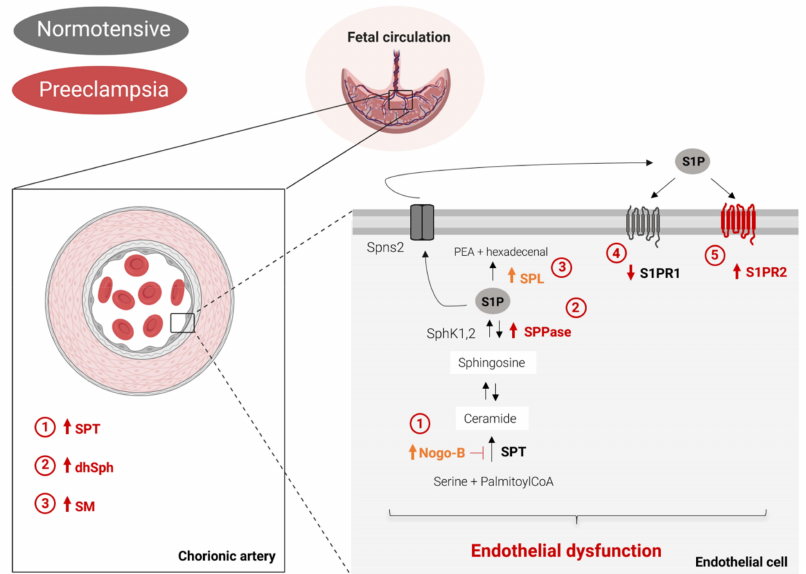
Figure 3. Summary scheme of PE-associated alterations of sphingolipid metabolism and signaling at the feto-placental vasculature. Left, PE is accompanied by increased SPT activity, accumulation of dhSph and increased SM production in chorionic arteries. Right, PE impairs the endothelial function by upregulating the expression of Nogo-B, SPPase, SPL and S1PR2, whereas it reduces the level of S1PR1 (statistically significant changes are depicted in red, whereas not statistically significant alterations are outlined in orange). SPT: serine palmitoyl transferase. KSR: 3-keto-dihydrosphingosine reductase. CerS: dihydroceramide synthase. DES: dihydroceramide desaturase. CDase: ceramidase. SM: sphingomyelin. SMS: sphingomyelin synthase. SMase: sphinglomyelinase. SphK1,2: sphingosine kinase. SPPase: sphingosine-1-phosphate phosphatase. S1P: sphingosine-1-phosphate. SPL: sphingosine-1-phosphate lyase. Spns2: spinster 2. S1PR1: sphingosine-1-phosphate receptor 1. The figure has been created with